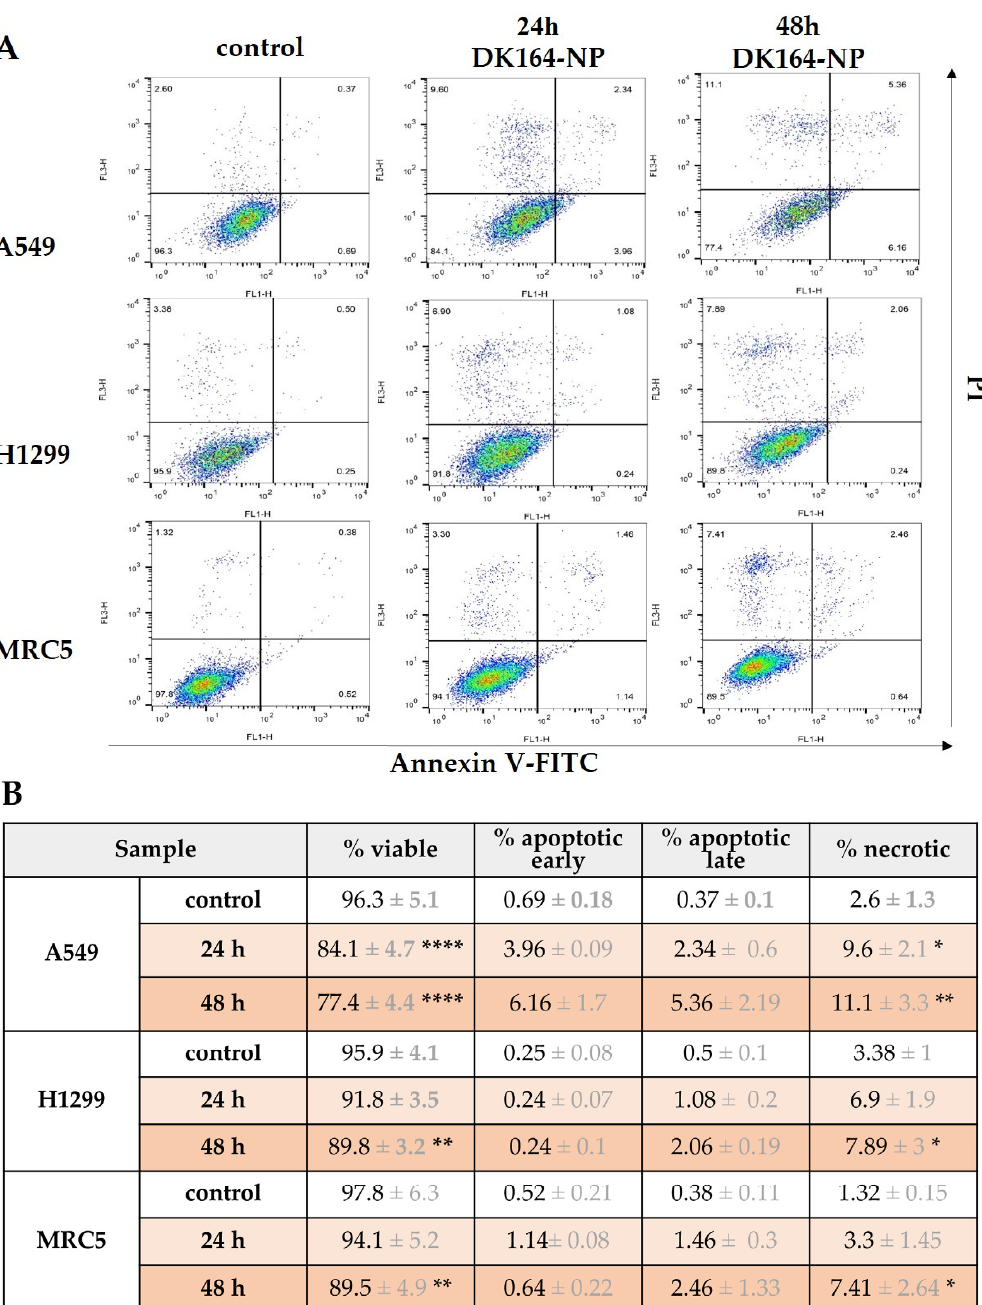
Figure 5. Cell apoptosis: ( A ) Flow cytometry histograms of A549, H1299 and MRC5 cells, treated with the calculated IC50 concentrations of DK164-NP for 24 h or 48 h and then stained with Annexin V-FITC and Propidium Iodide (PI). The four quadrants in each panel correspond, respectively, to: necrotic cells (upper left); late apoptotic cells (upper right); early apoptotic cells (low right); viable cells (low left); ( B ) Quantitative analysis of the flow cytometry results from at least three independent experiments (n = 3) ±SD. Multiple comparisons function of two-way ANOVA (Tukey’s multiple comparison test) was used to compare the mean of treated samples with the mean of control column.